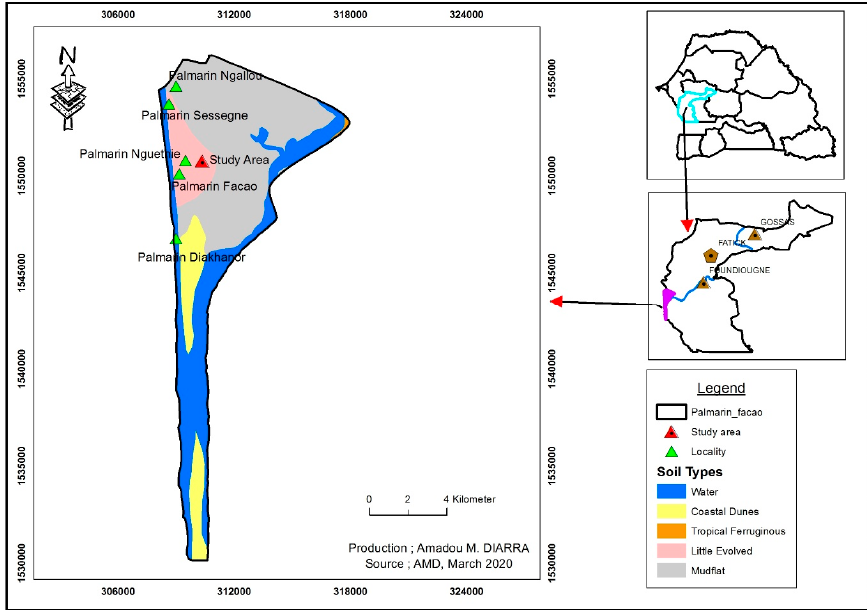
Figure 1. Map of the study site in Palmarin (Fatick, Senegal).